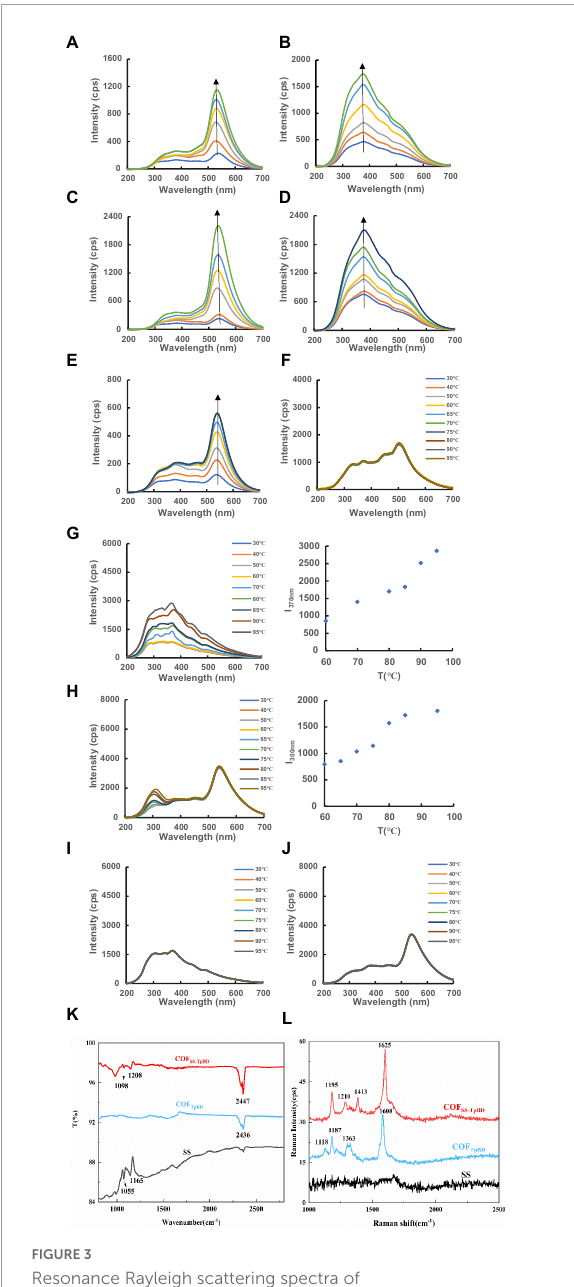
FIGURE3 Resonance Rayleigh scattering spectra of